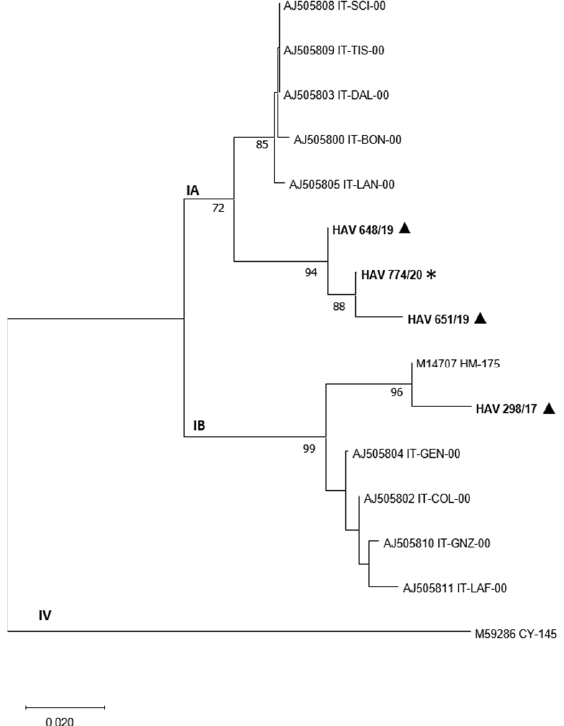
Figure 1. Neighbor-joining phylogenetic tree based on the partial VP1 nucleotide sequences of HAV. Sequences obtained in this study including those from gastropods (asterisk) and those from bivalve molluscs (triangle) are in bold. Sequences retrieved from GenBank are reported with the isolate name and the accession number. Bootstrap values > 70% are shown. Branch lengths are scaled according to the number of nucleotide substitutions per site. The scale bar is reported.